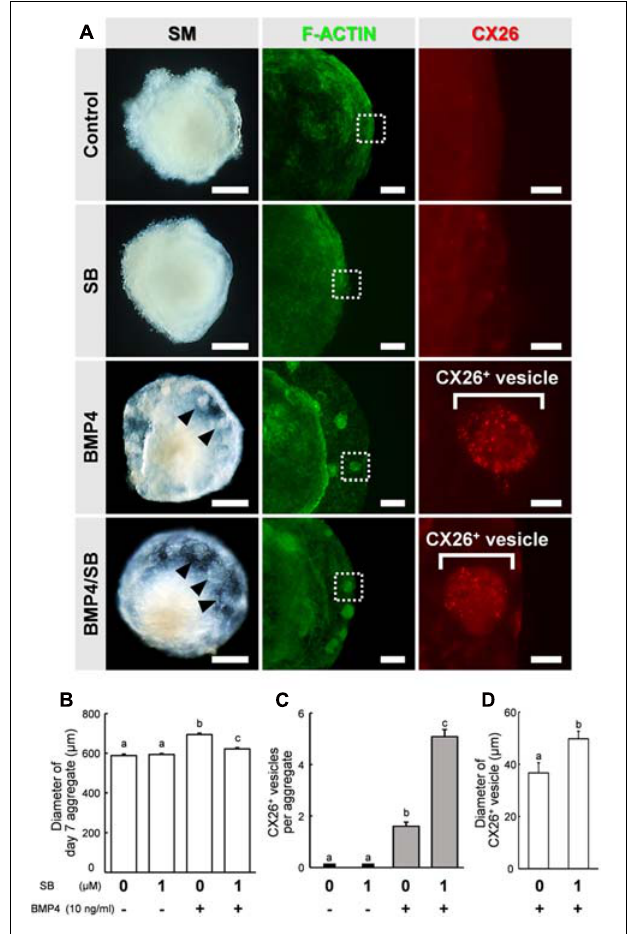
FIGURE 2 | Stereomicroscopic images and immunostained aggregates derived from ESCs after 7 days in SFEBq cultures. (A) Left column: stereomicroscopic (SM) images of cells on day 7. Middle column: cells immunostained for F-actin (green). Right column: higher-magnification image of the boxed regions in the middle columns, showing immunostaining for CX26 (red). Arrowheads point to small vesicles. Scale bars, 200 µ m (left column); 100 µ m (middle column); 20 µ m (right column). (B) Average diameter of day 7 aggregate ( n = 15–32 aggregates from two to four independent experiments). (C) The average number of CX26 + vesicles per aggregate ( n = 24 aggregates from three independent experiments). (D) Average diameter of CX26 + vesicles in day 7 aggregate ( n = 12–24 CX26 + vesicles from three independent experiments). The data are expressed as the mean ± SE. Statistical differences among treatments were assessed by one-way ANOVA and Scheffe’s multiple comparison test, or Student’s t -test. Different letters (a–c) represent significant differences, p <